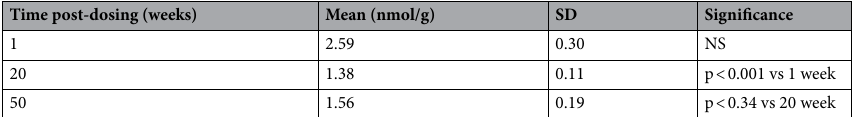
Table 1. ICP-MS measurement of brain gadolinium in whole brain in rats administered a cumulative dose of 12 mmol/kg over 5 weeks (n = 6 per group). Ns not significant. Statistical analyses using a one-way ANOVA with a Dunnet’s post-hoc test.